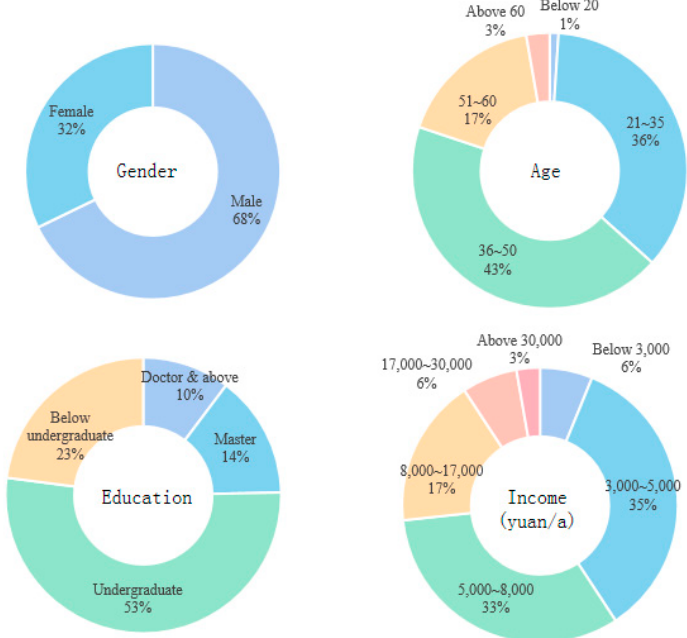
Figure 2. The distribution for sample data regarding gender, age, education, and income.